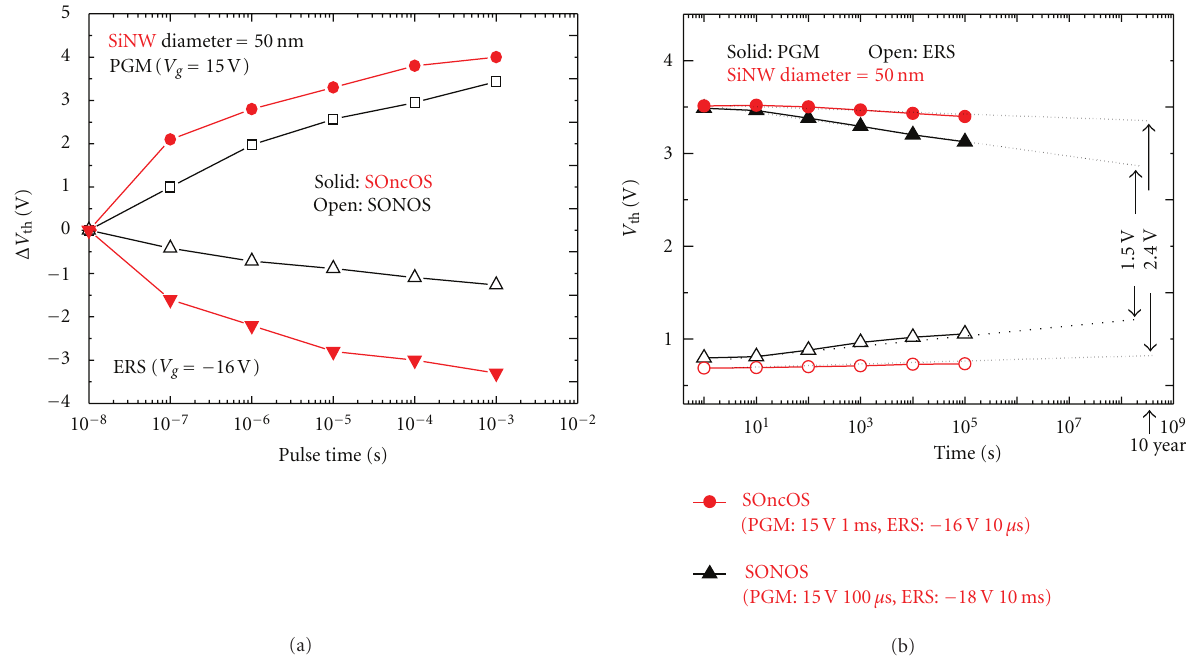
Figure 13: (a) Comparison of P/E speed between vertical SiNW-based NC-SOncOS and SiN-SONOS, with gate length of 150 nm and wire diameter of 50 nm. (b) Retention characteristics at 85 ◦ C for vertical SiNW-based GAA SONOS and NC-SOncOS. (Reprinted with permission from [45]. [2011] IEEE.)